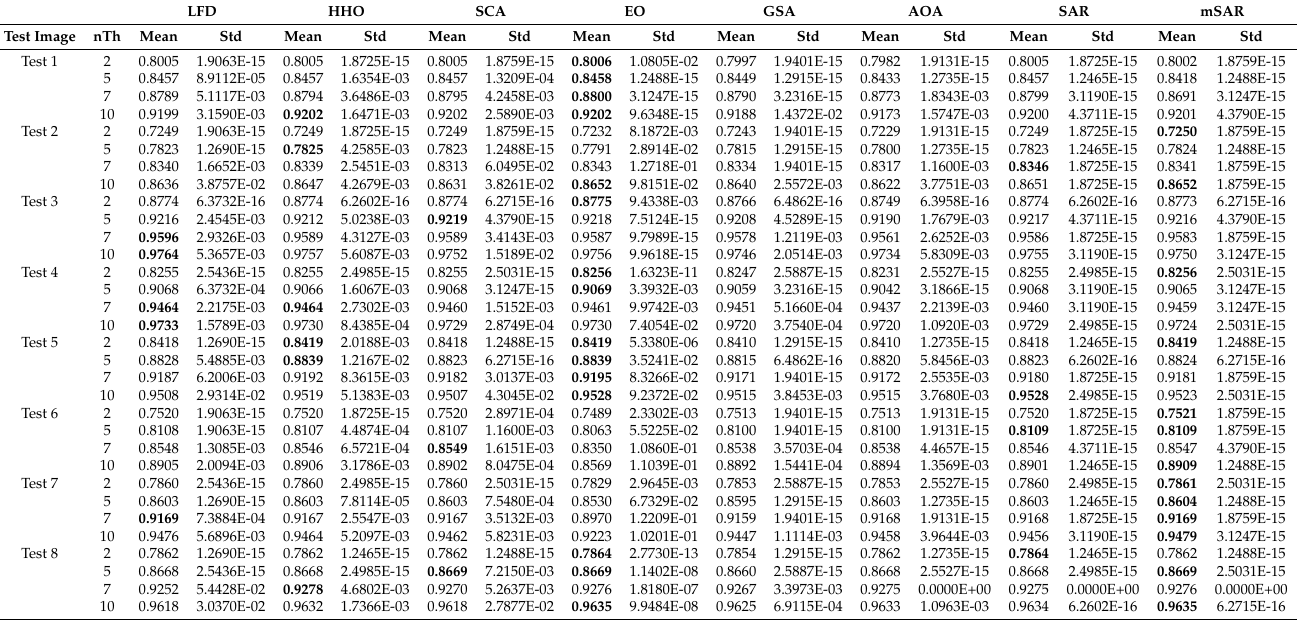
Table 11. mSAR Otsu in terms of FSIM values overall competed for